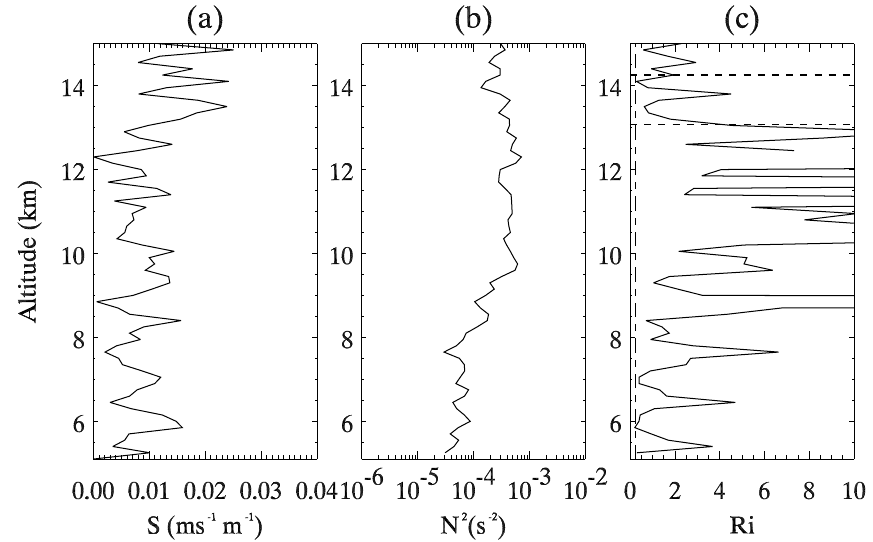
Fig. 3. Height variations of (a) the horizontal wind shear S , (b) the Br¨unt V¨ais¨al¨a frequency N 2 and (c) the Richardson number Ri = N 2 /S 2 . N 2 is obtained from temperature and pressure measurements by a balloon launched at 00:43LT and the wind shear, measured by the MU radar, is averaged from 22:39 to 00:46LT. The horizontal dotted lines in (c) correspond to the analyzed range shown in Figs. 5a. The vertical dotted-dashed line in (c) indicates the critical Richardson number of 0.25 which is necessary for dynamic